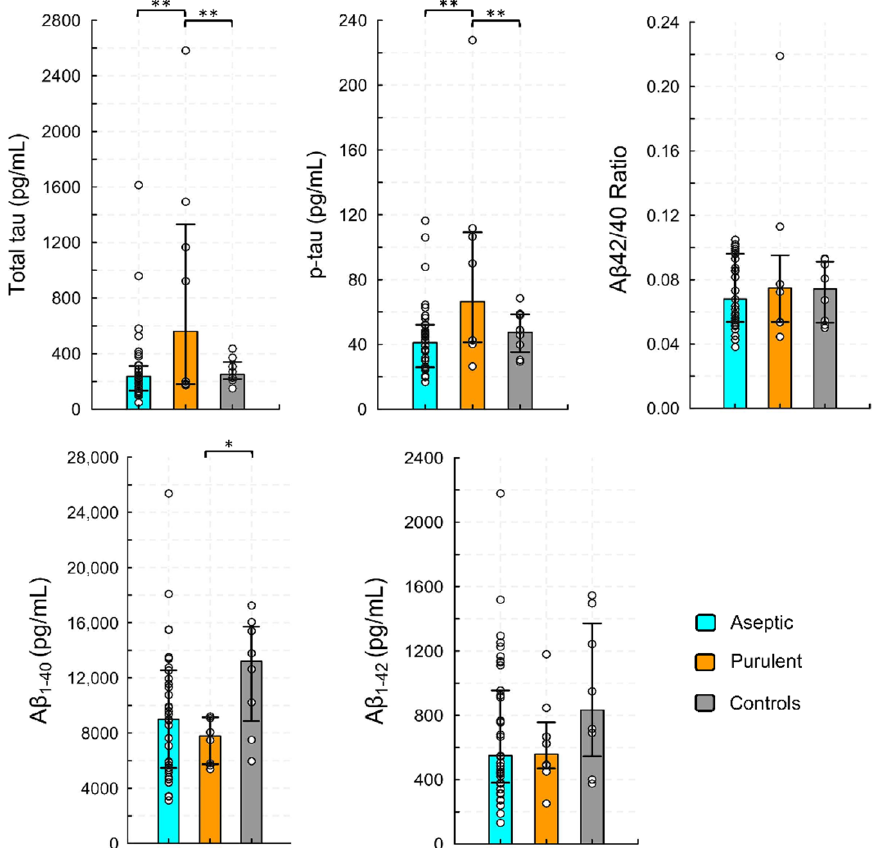
Figure 2. Cerebrospinal fluid concentrations of biomarkers of Alzheimer’s disease in children with infections of the central nervous system, divided by the type of infection. The aseptic group comprises children with viral infections of the CNS and children with Lyme neuroborreliosis ( n = 37). The purulent group comprises children with purulent bacterial infections of the CNS ( n = 8). Bars represent medians, whiskers represent interquartile range, and dots show the raw data. * indicates p < 0.05. ** indicates p <